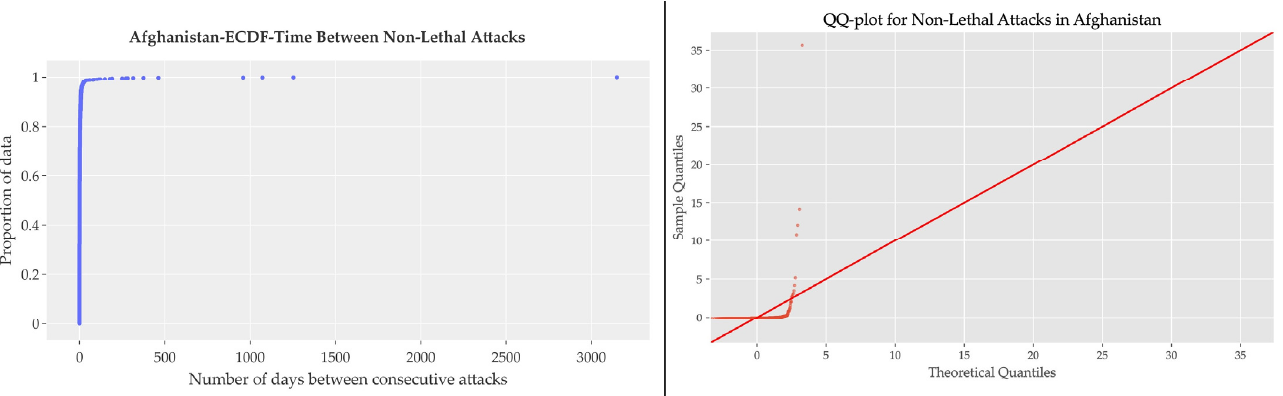
Figure 3. The time between consecutive lethal attacks and the corresponding QQ plot for Afghanistan.